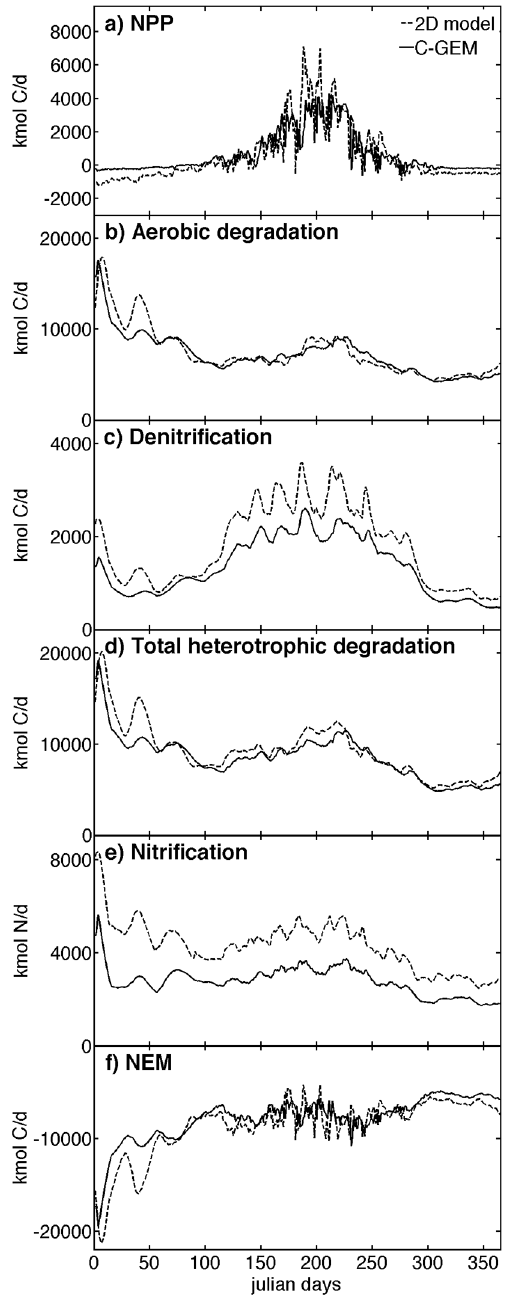
Figure 11. Comparison between annual evolution of biogeochemi- cal rates modeled by C-GEM (solid line) and the 2D-RTM (dashed line) by Arndt et al.